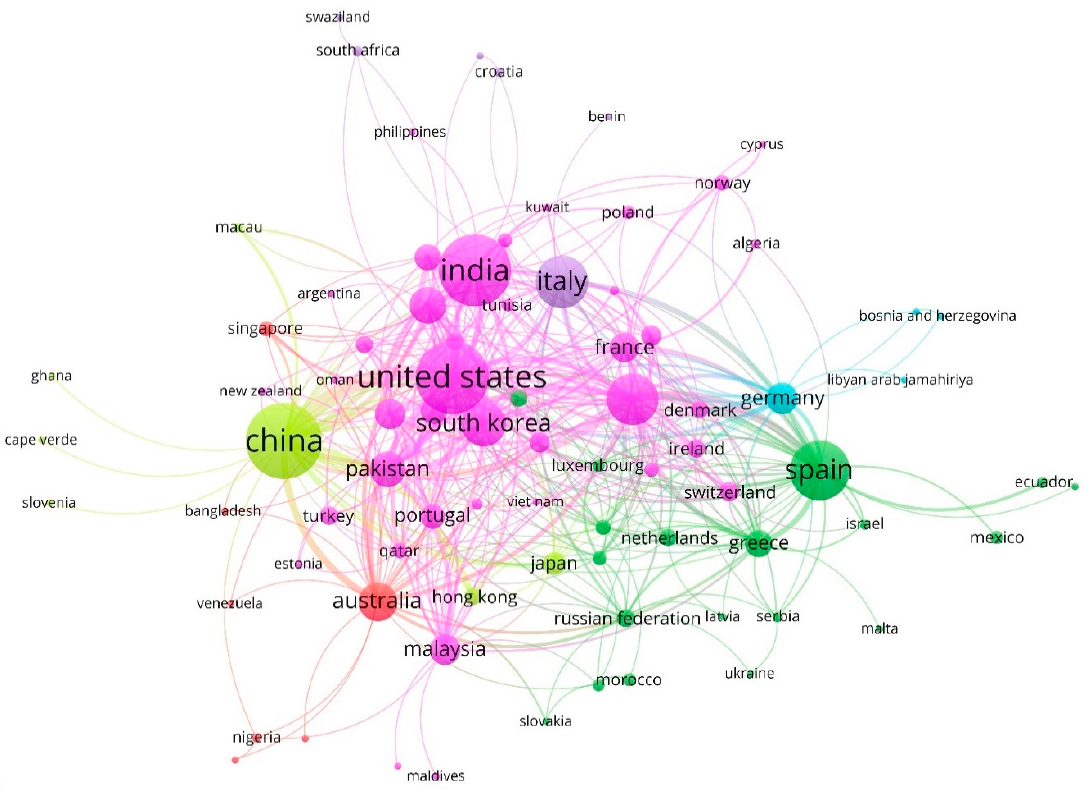
Figure 8. Countries network based on the co-authorship method (2011–2019).